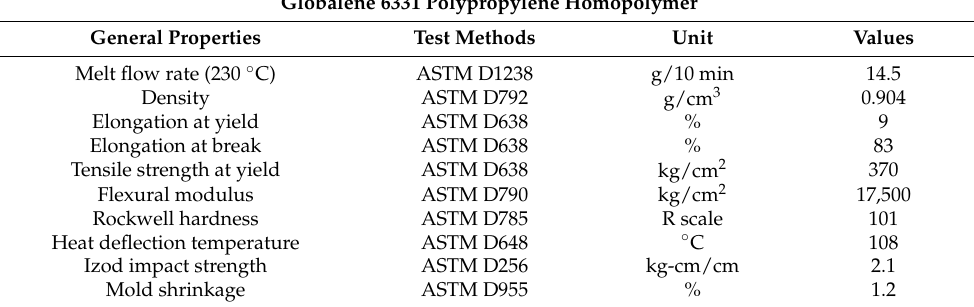
Table 1. Polypropylene properties